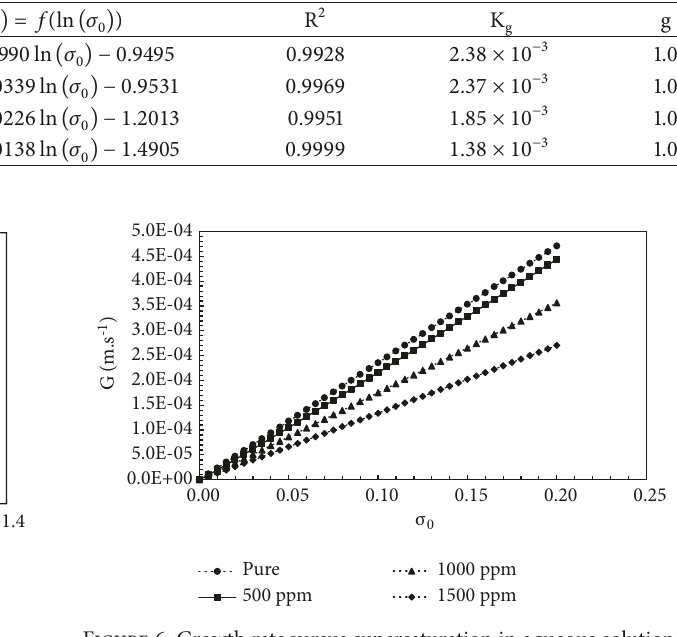
Figure 6: Growth rate versus supersaturation in aqueous solutions without and with